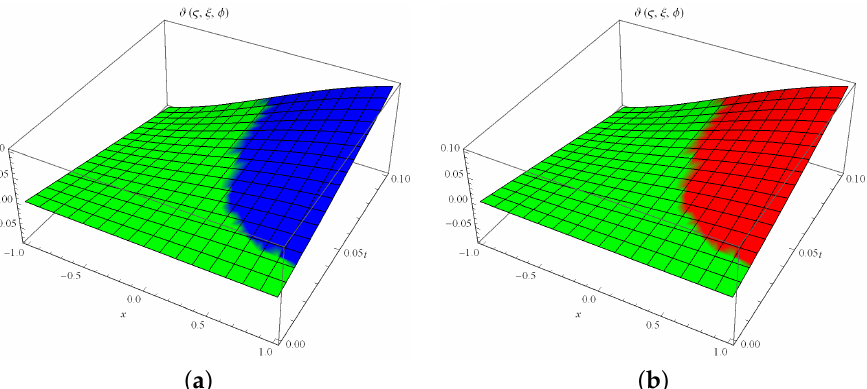
Figure 3. Surface solutions of 2D wave equation. ( a ) Surface plot for approximate results. ( b ) Surface plot for precise results.